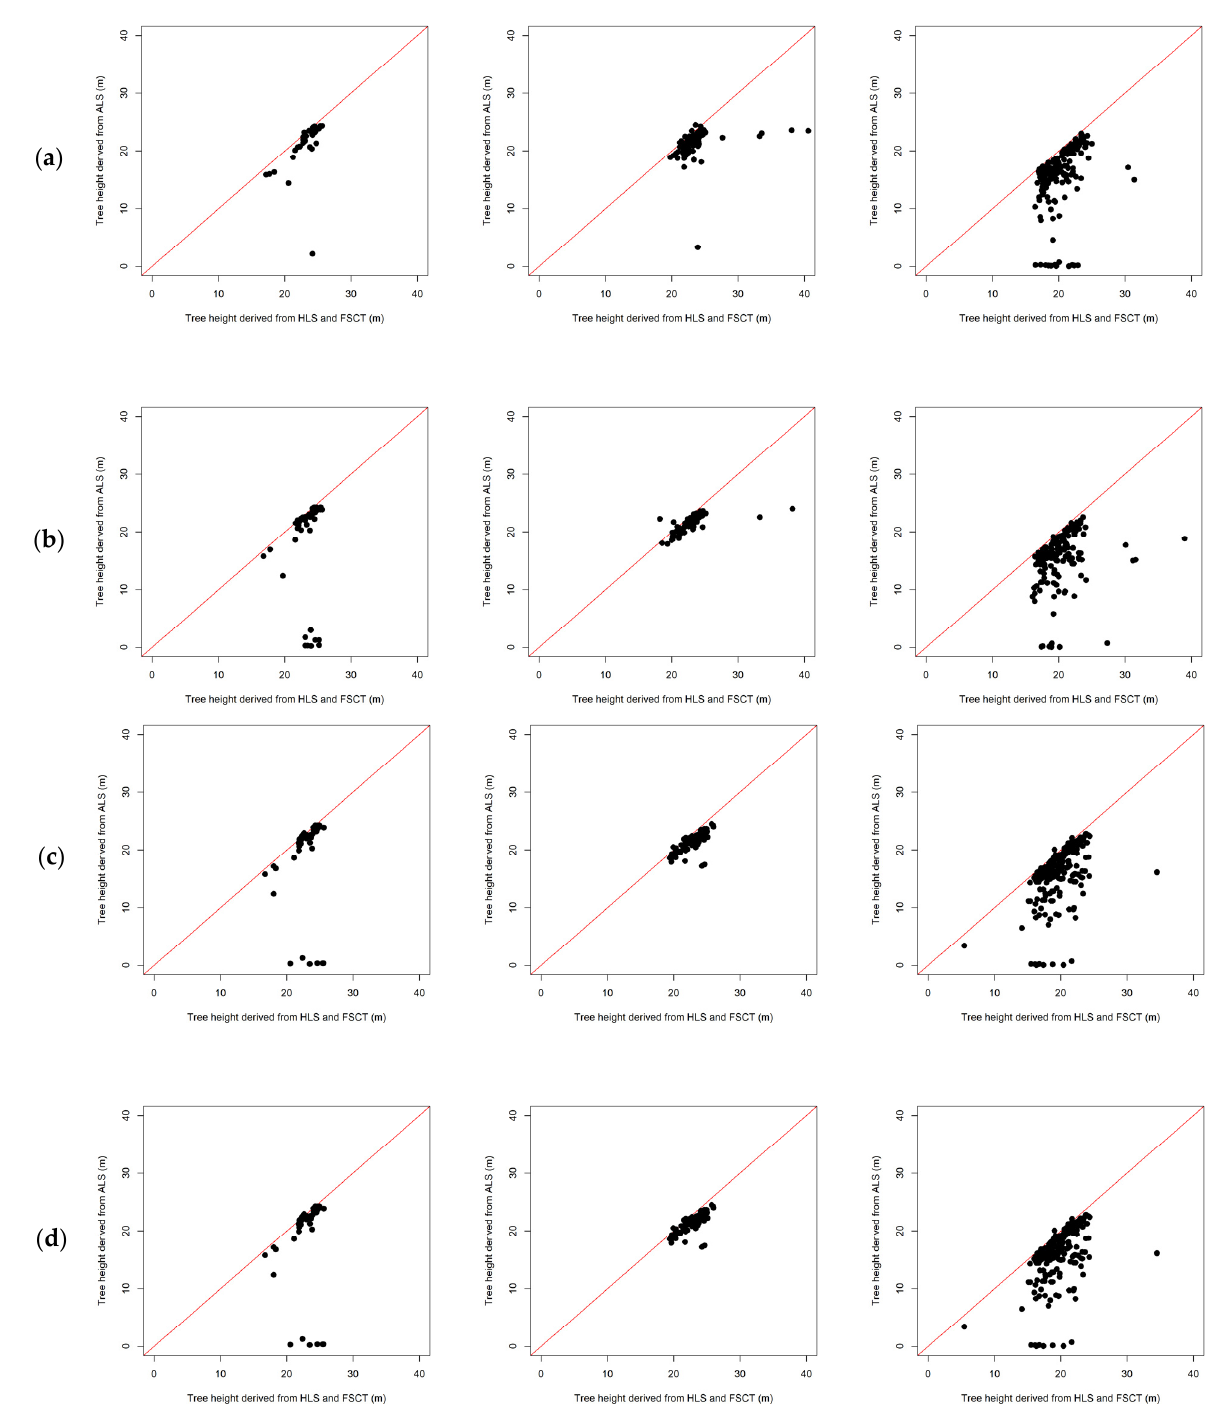
Figure 10. Relationship between scanned height using handheld laser scanning (HLS) and the Forest Complexity Tool and height estimates from airborne laser data (ALS). Results are presented for Scan 01 in rigid and none‑rigid modes (( a , b ), respectively), and for Scan 02 (( c , d ), respectively). First column is Alnus glutinosa (Ag), second column is Pinus pinaster (Pp) and third column represent observations of Quercus pyrenaica (Qp).